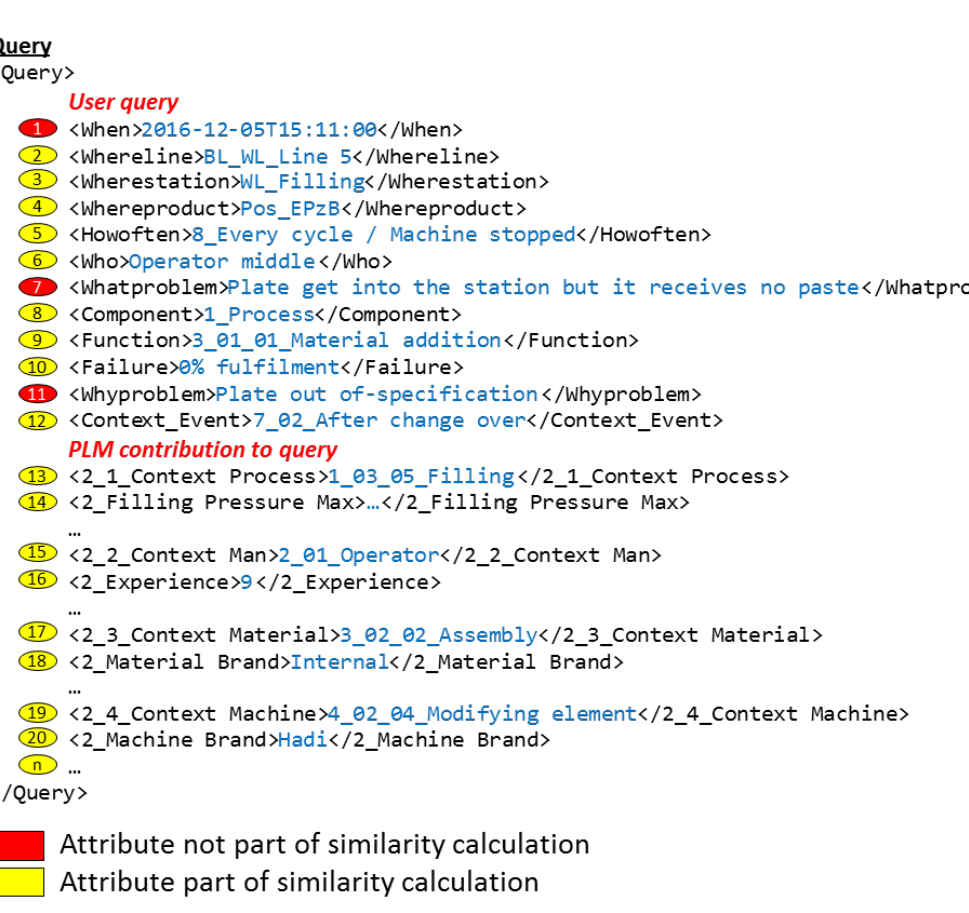
Figure 11. Weights for global similarity calculation.